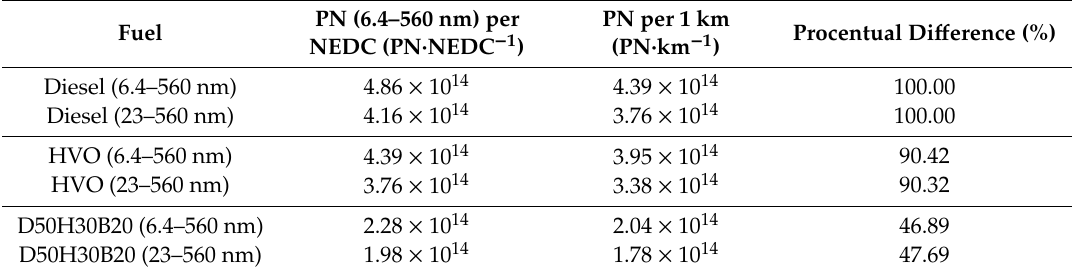
Table 10. Total PM production in NEDC driving cycle.